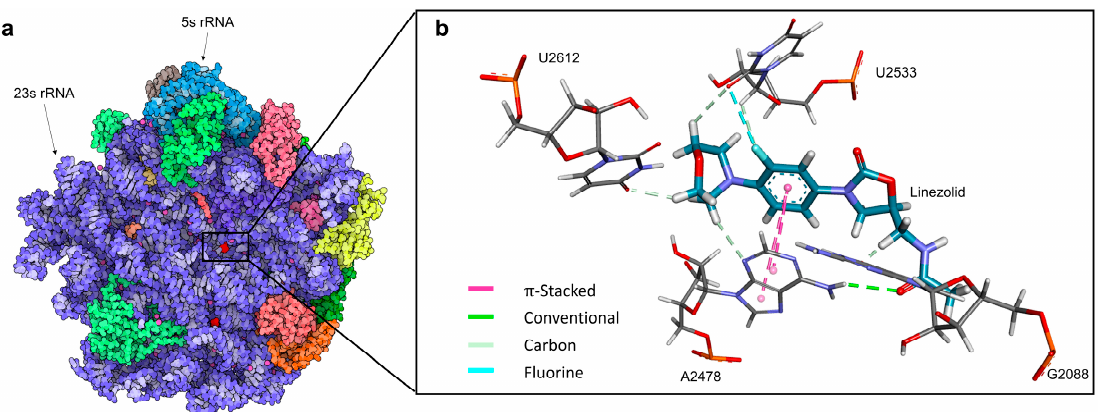
Figure 1. The S. aureus (strain NCTC832) 50S ribosome crystal structure (PDB ID 4WFA) with 50S ribosomal proteins (not all proteins are shown for clarity) and 5s and 23s rRNA ribosomes coloured and labelled with ( a ) rotated side view of the crystal structure with the linezolid binding site displayed. ( b ) Close-up view of the linezolid at the ribosomal binding site. Linezolid is shown in aqua blue, while the residues that interact in the active site are coloured by element and labelled with their corresponding residue name, with E. coli rRNA numbering. The interactions between the S. aureus residues and the ligand in the binding pocket are shown via the striped line, coloured by the following interactions: π -stacked (pink), conventional (bright green), carbon (light green), and fluorine (blue). Images were created using Protein Imager [4] and BIOVIA Discovery Studio Visualizer